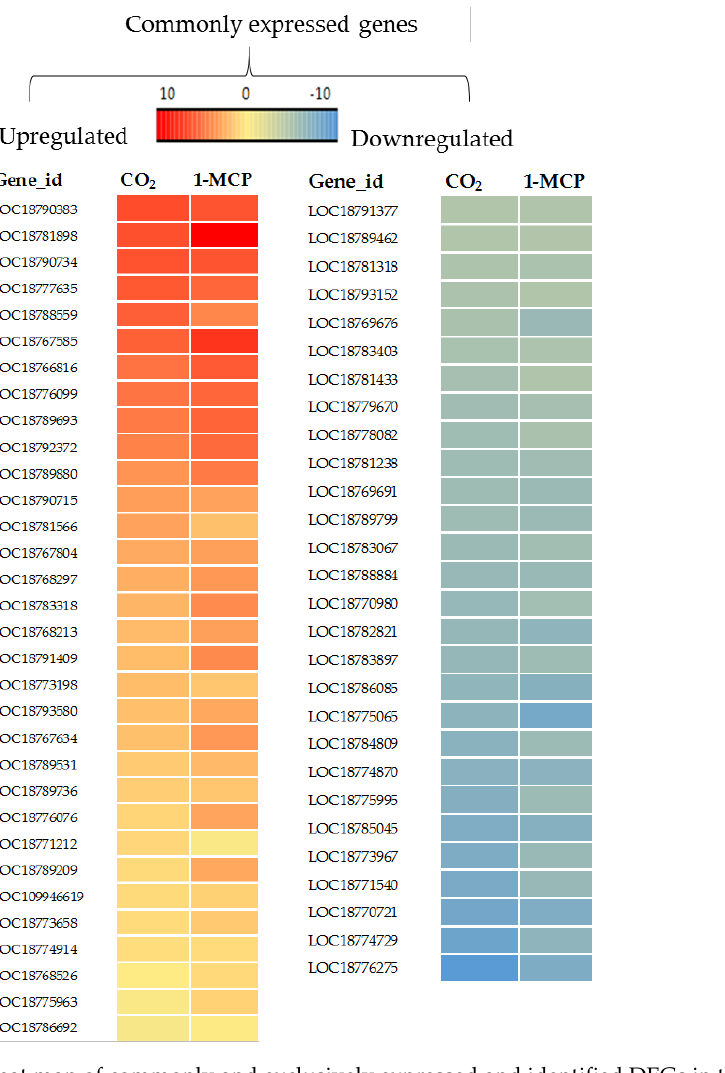
2 +CS and 1-MCP+CS ‘Madoka’ peach fruit after 12 days